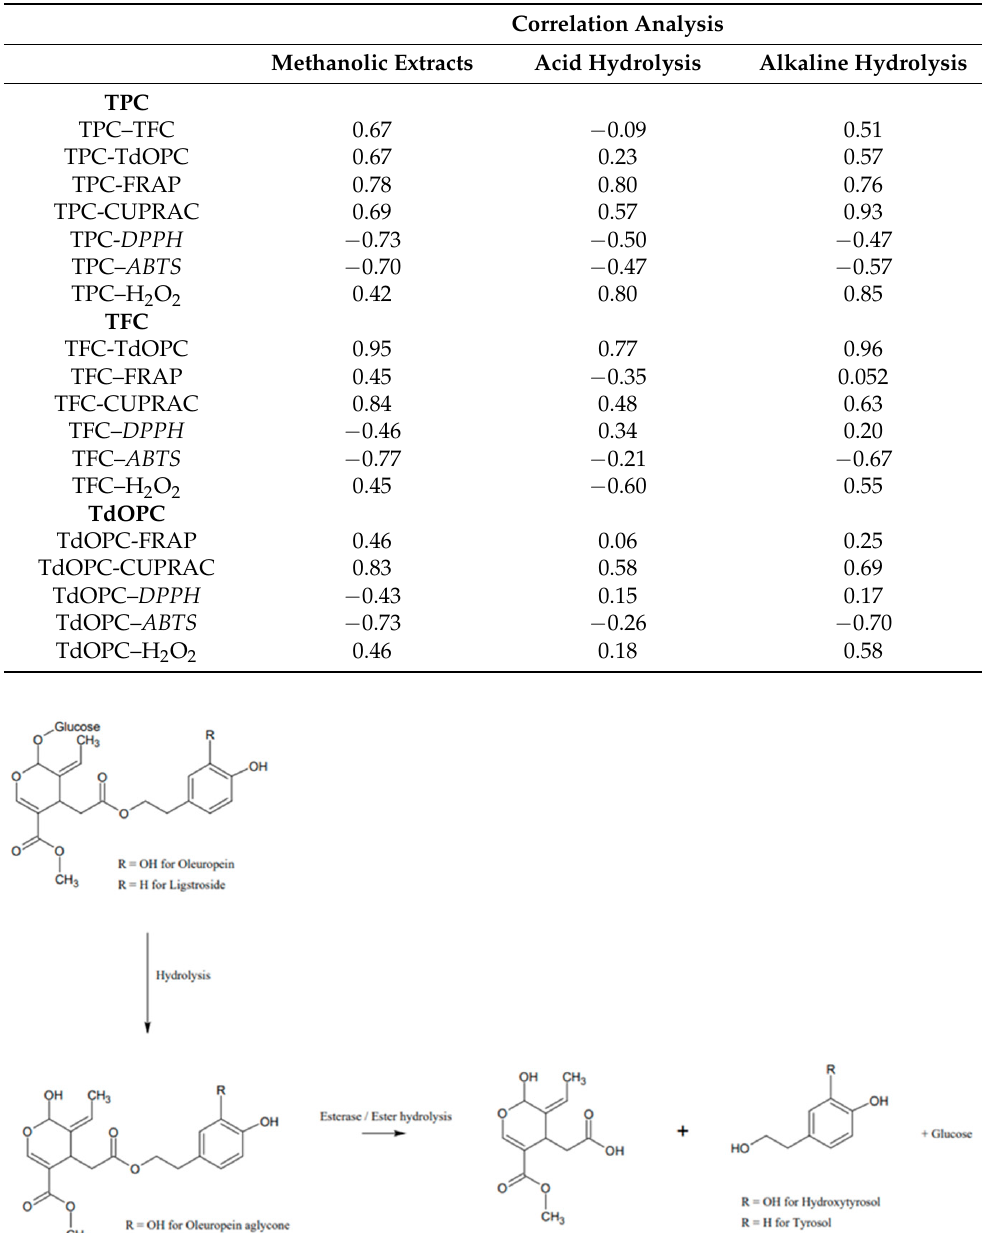
Table 4. Correlation analysis between all assays.